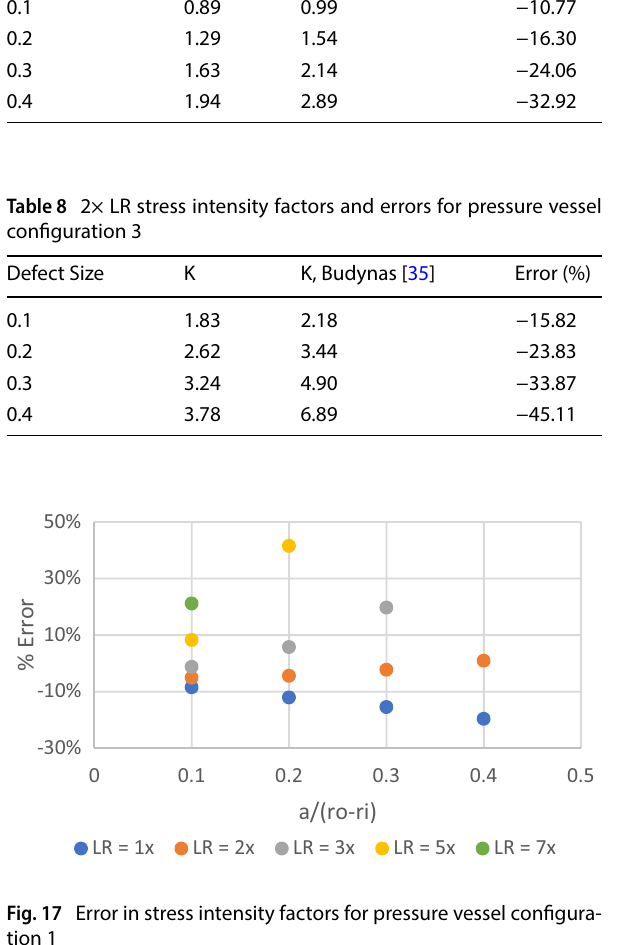
Fig. 18 Error in stress intensity factors for pressure vessel configura- tion 2